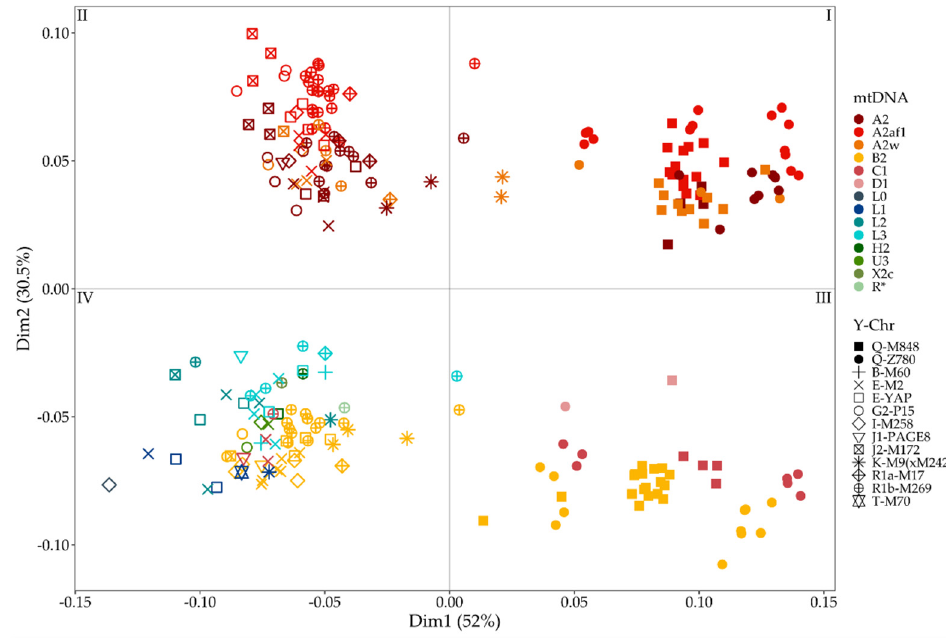
Figure 6. MDS plot computed on the mean of mtDNA and Y-chromosome pairwise distances.